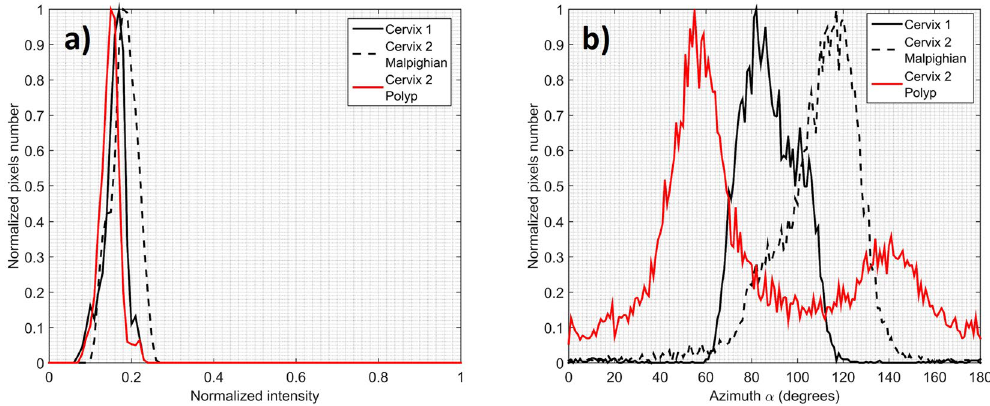
Figure 7. Histograms of Intensity ( a ) and Azimuth ( b ) of areas delineated in Fig.